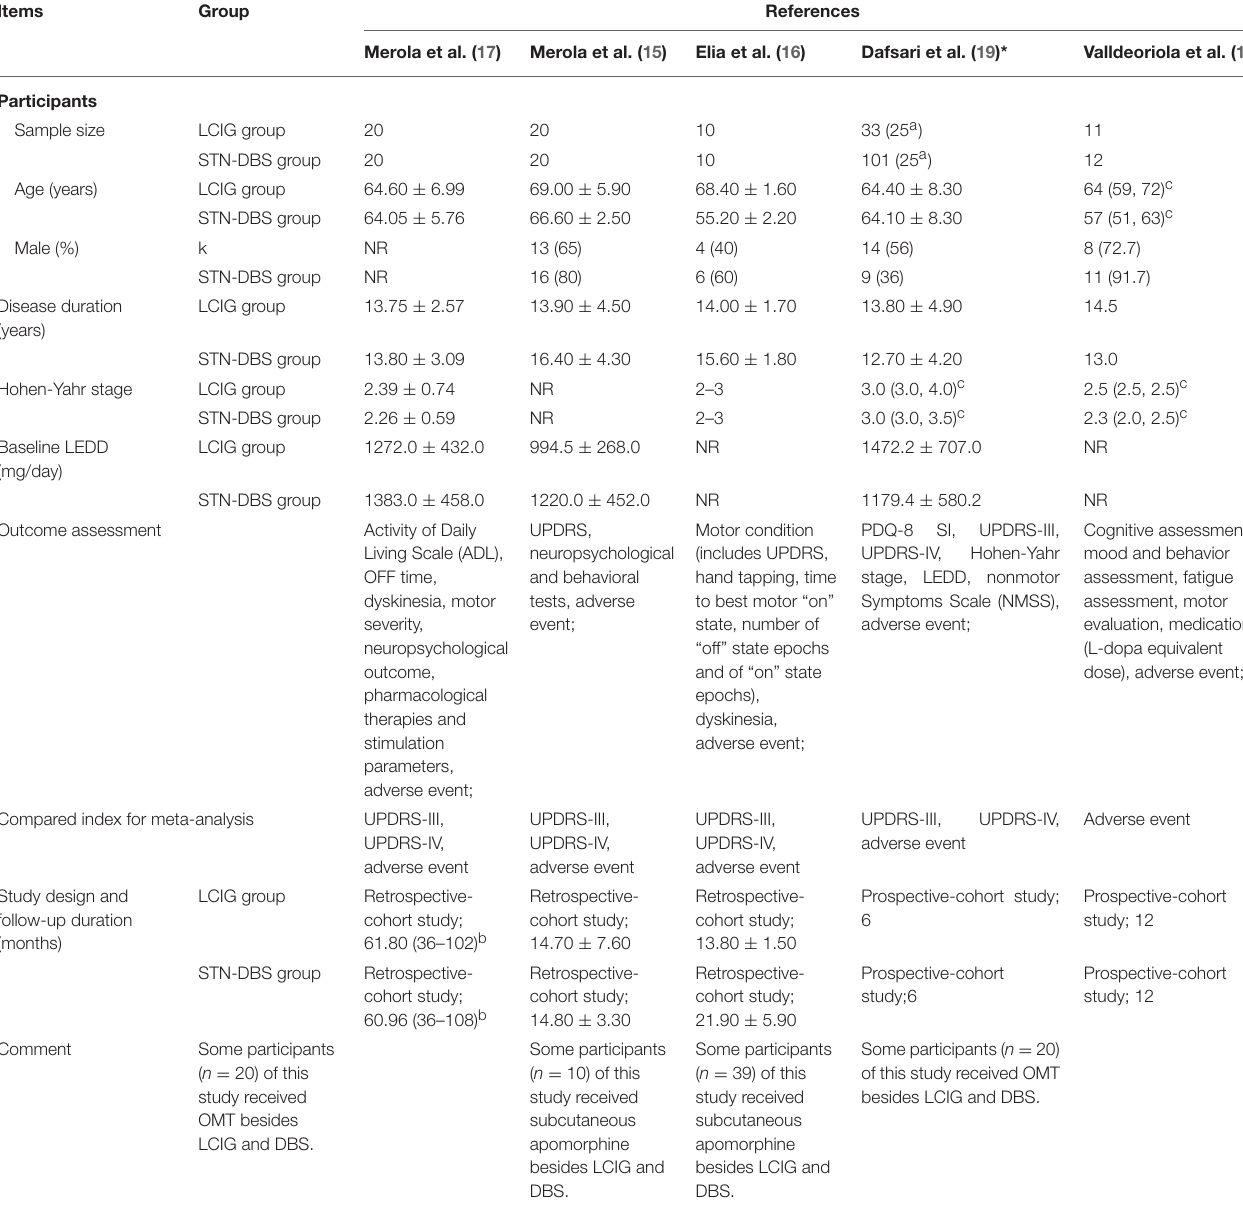
TABLE 2 | Characteristics of included